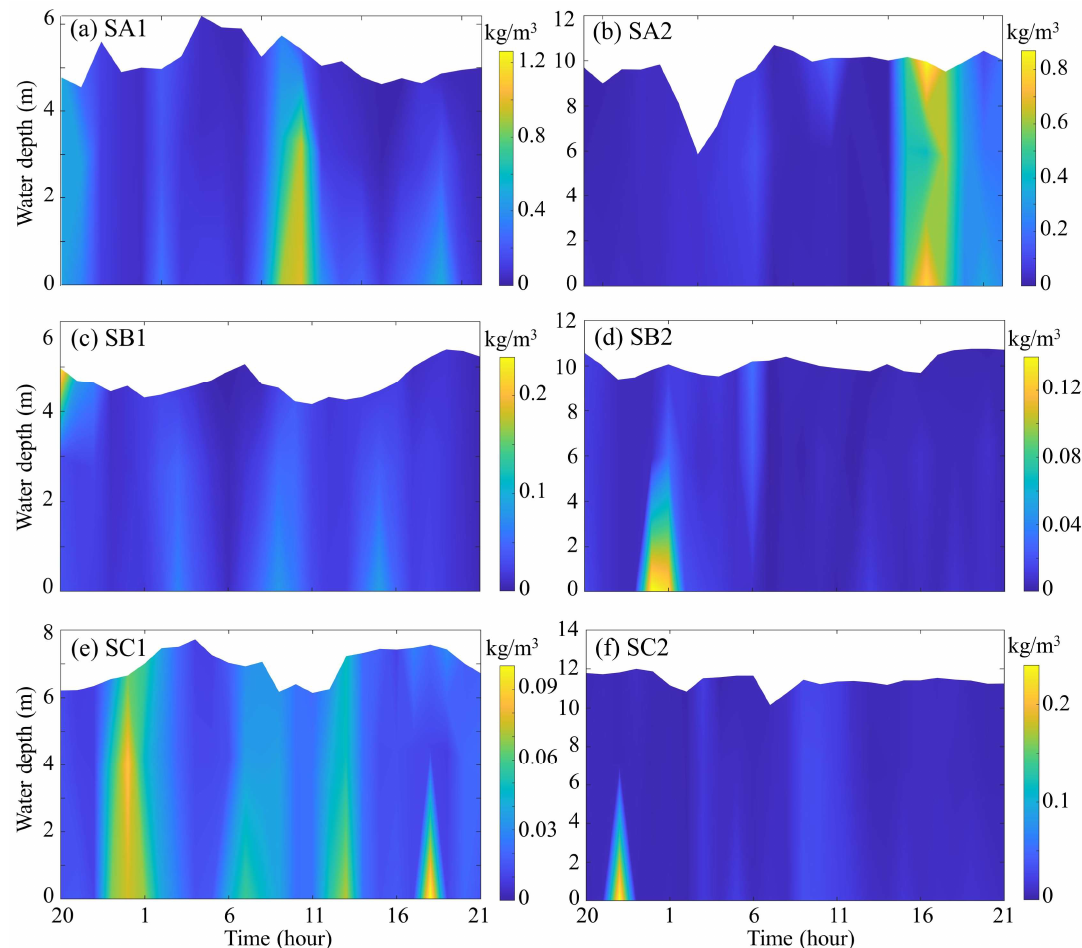
Figure 12. Vertical distribution of SSC at six sites (a–f) during spring tide in July 2019.